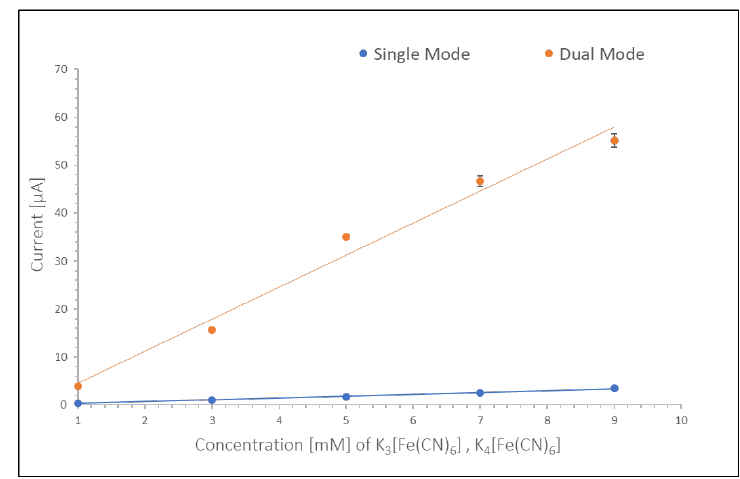
Figure 3. Calibration curve for single and dual mode, platinum IDA, stationary measurements.